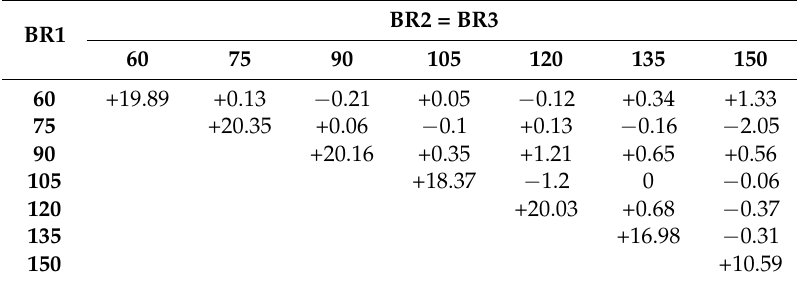
Table 6. Comparison between [15] and the Feature fusion F 1 of this algorithm—FAAC (%).